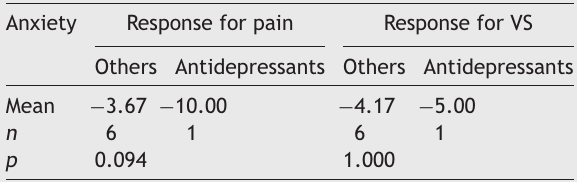
VAS, visual analog scale; VS, vestibular symptoms.